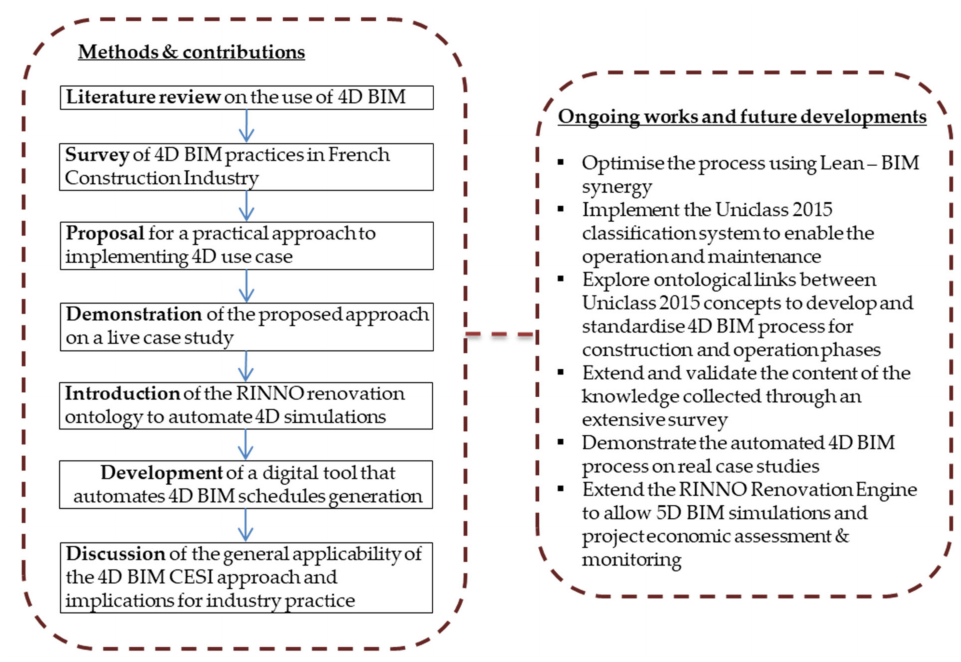
Figure 1. Methods, contributions, ongoing works, and future developments presented in this